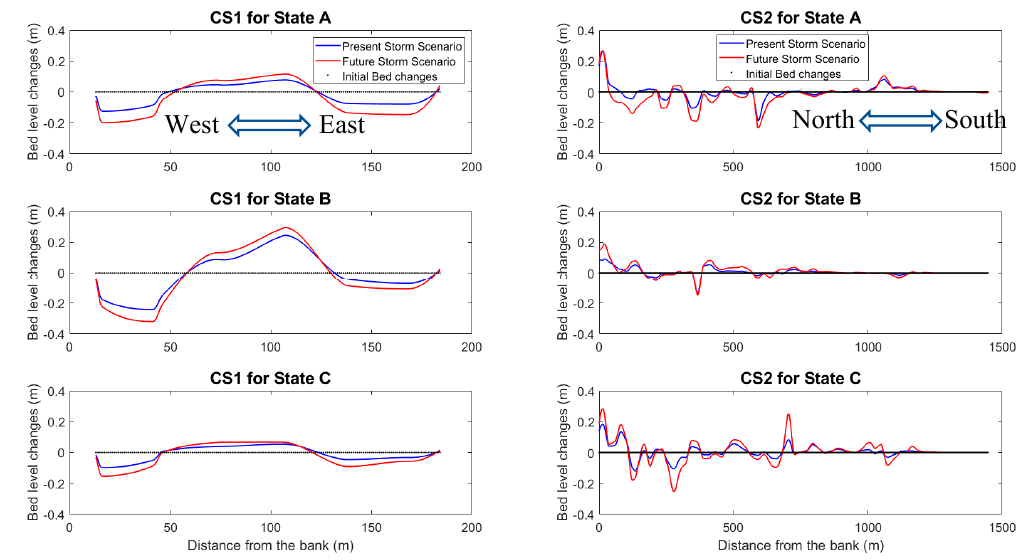
Figure 14. The comparison of bed level changes at ‘CS1 ′ (left) and ‘CS2 ′ (right) cross sections under ‘present’ and ‘future’ storm scenarios. State A (top), State B (middle), and State C (bottom).